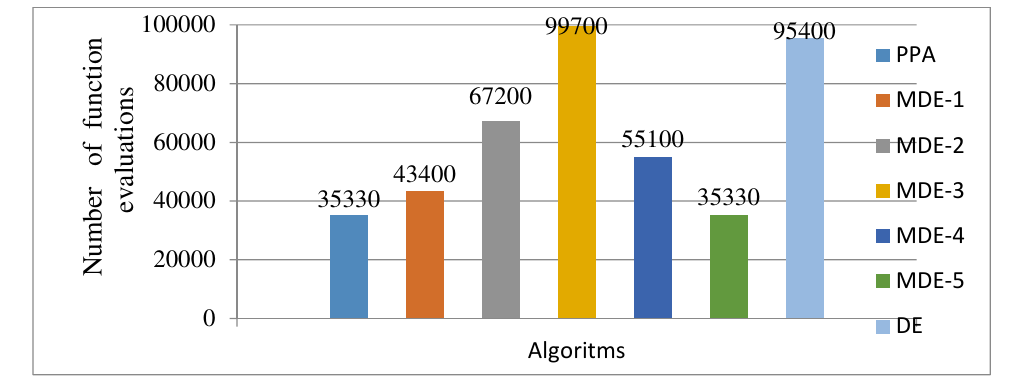
FIG. 7: NUMBER OF TOTAL FUNCTION EVALUATIONS TAKEN BY PPA, DE AND ITS VARIANTS IN SOLVING THE 4-BUS PROBLEM OF DOCRS .